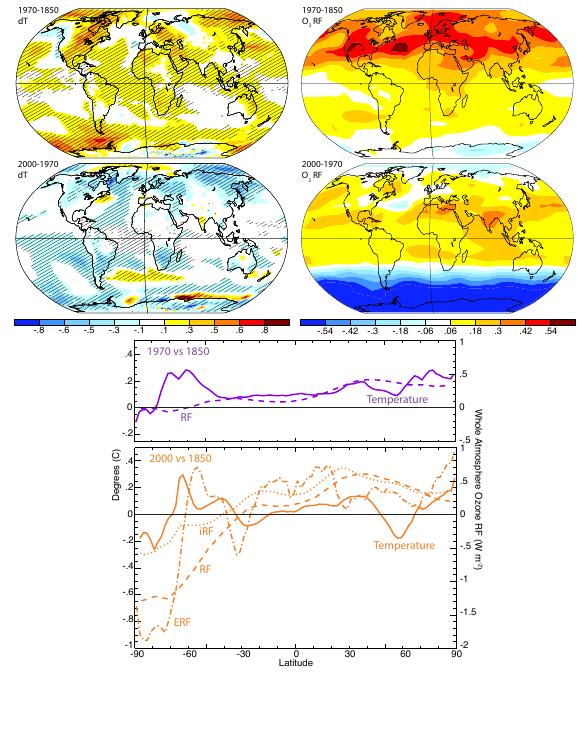
Fig. 25. Annual average surface temperature changes (C; left maps) and whole atmosphere ozone RF (W m − 2 ; right maps) over the given time periods and zonal mean annual average surface tempera- ture changes and ozone forcing for the indicated definitions of forc- ing (line plots). Hatching in the left column maps indicates 95% statistical significance for the ensemble mean response relative to the control variability.